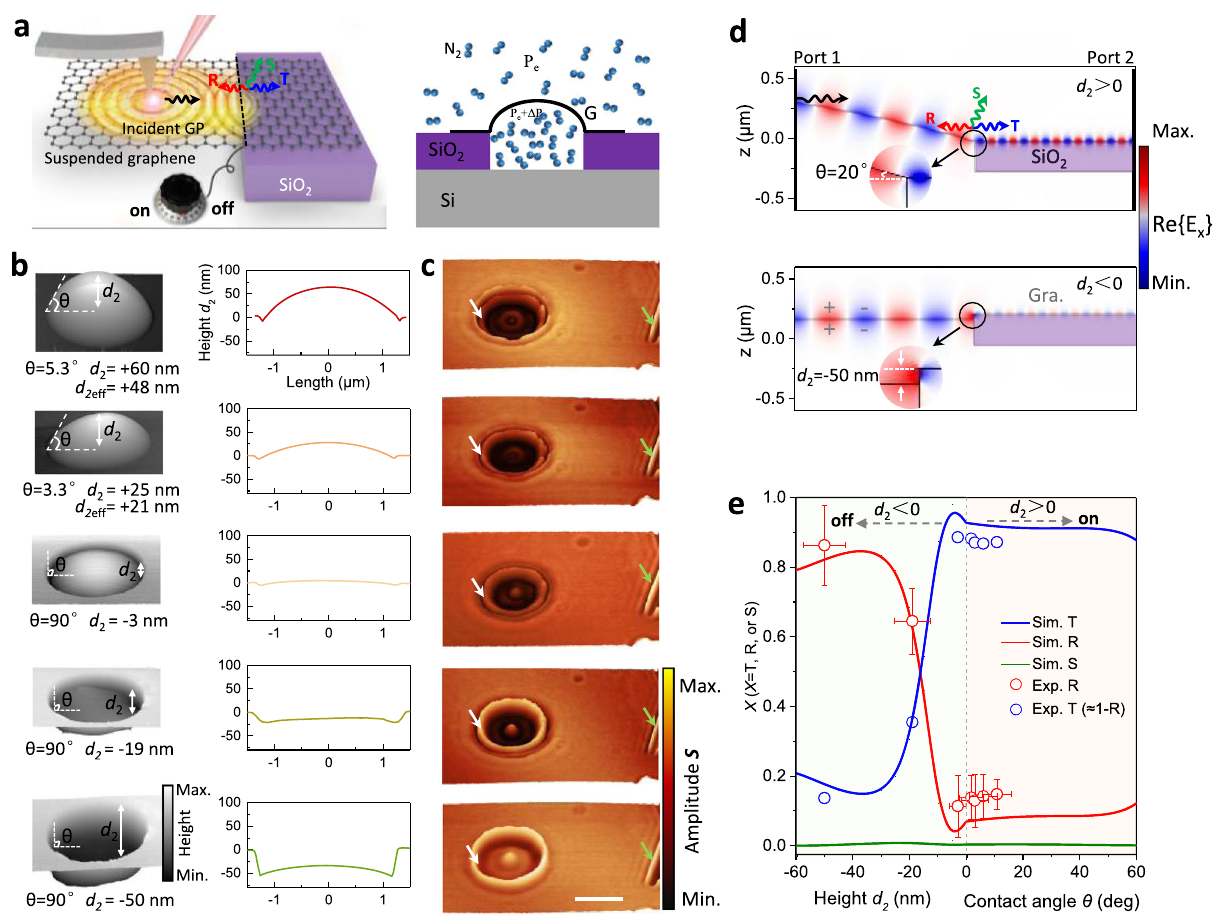
Fig. 4 Plasmonic switch based on tunable control of GP transmission at air-dielectric substrate interfaces. a Schematic of the plasmonic switch. Black, red, and blue arrows represent incident, re fl ected, and transmitted plasmons, respectively. The green arrow stands for plasmon scattering (out-coupling) into radiation. The black-dashed line indicates the air-dielectric interface. b AFM topography images of suspended graphene with different heights of the graphene bubble d 2 , obtained by controlling the gas pressure for fi xed hole depth d 1 = 300 nm (see de fi nitions in the inset of Fig. 3b). A negative value of d 2 indicates that the graphene bubble is sunken inside the substrate dimple. We use a sample with a large value of d 1 to avoid any complications in the interpretation. θ is the contact angle of suspended graphene and the substrate. c Near- fi eld IR images of suspended graphene, taken simultaneously with the AFM topography for the corresponding suspension heights shown in ( b ). The incident light wavelength is λ 0 = 10.87 μ m (920 cm − 1 ), and the graphene Fermi energy is 0.40 ± 0.03 eV. Since the entire sample is treated with the same gas concentration and doping time, we assume that the graphene has the same Fermi energy in the substrate and suspended regions. The bright fringes at the air-dielectric interface and natural graphene edge are indicated by white and green arrows, respectively. The scale bar indicates 2 µ m. d Simulated spatial distribution of the electric fi eld along the x direction as GPs propagate from the suspended region to the region supported by the SiO 2 substrate, with d 2 > 0 (upper part) and d 2 < 0 (bottom part). Inset: expanded view of the boundary area. e Plasmon re fl ectance (red), transmittance (blue), and scattering (green) as a function of d 2 and θ . Colored curves are numerical simulations with E F = 0.4 eV, whereas symbols represent experimental results extracted from ( c ). The vertical dashed line and two shaded areas are used to indicate the two cases where the suspension height is positive or negative. Error bars are extracted from different line pro fi les in each scanned